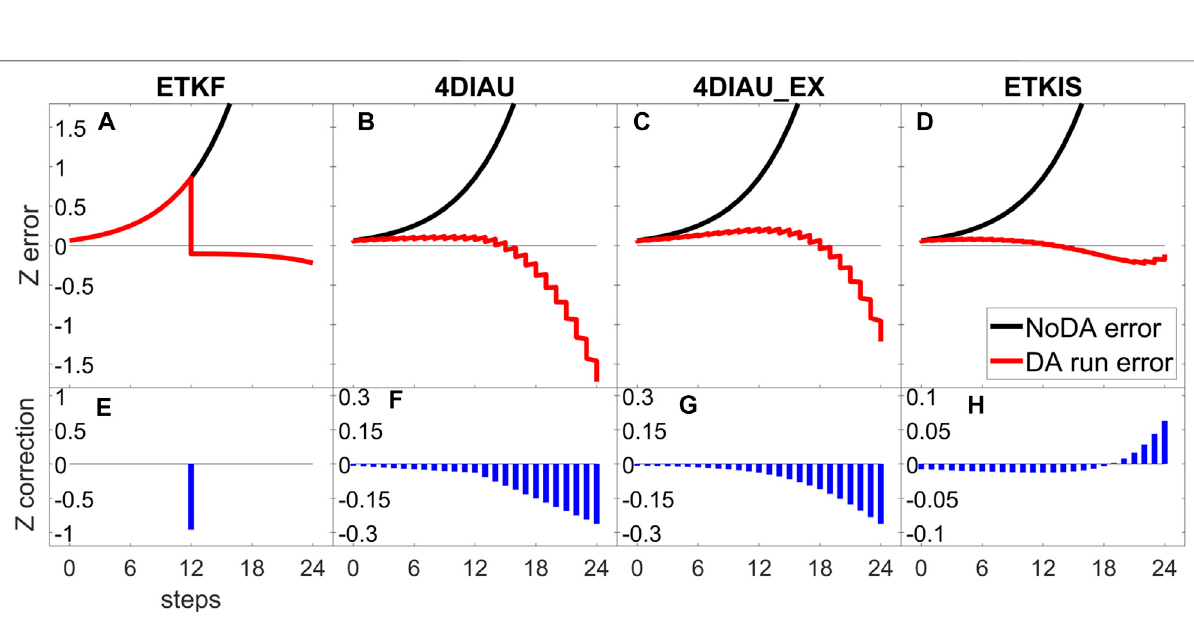
Frontiers in Applied Mathematics and Statistics |